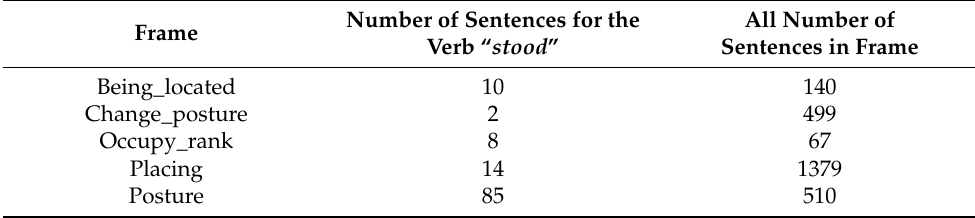
Table 2. Statistics for the verb “ stood ” in the FrameNet